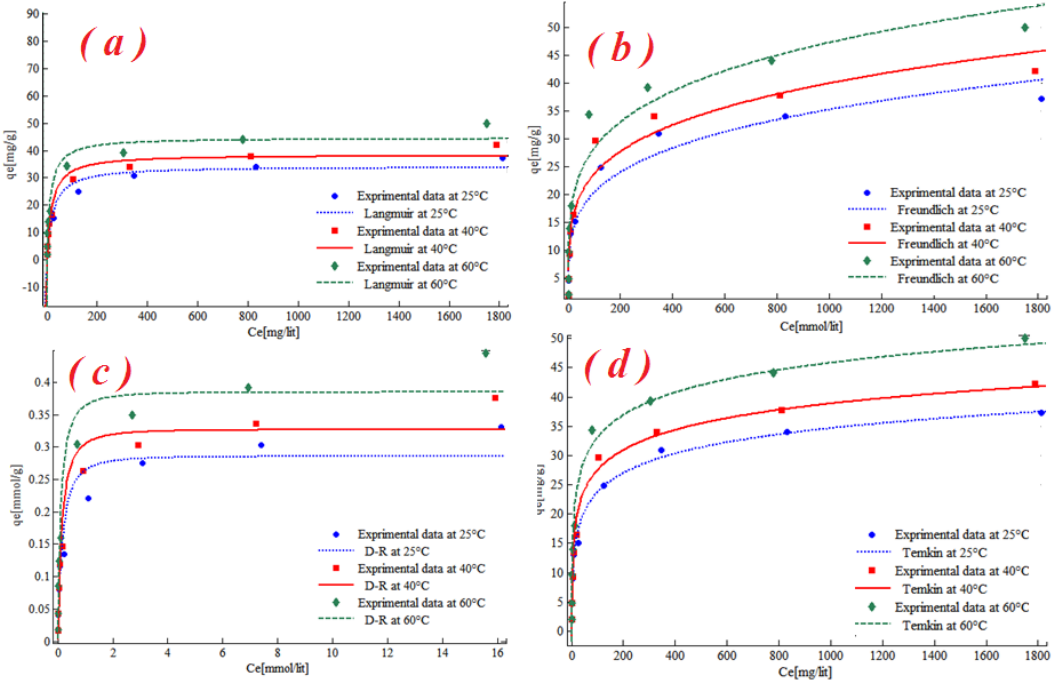
Fig. 5: the sorption isotherms of (a-d) Cd(II), at different temperatures on modified zeolite. Table 2. The Langmuir, Freundlich, Temkin and Dubinin-Radushkevich (D-R) constants and correlation coefficients of isotherm models at different temperature